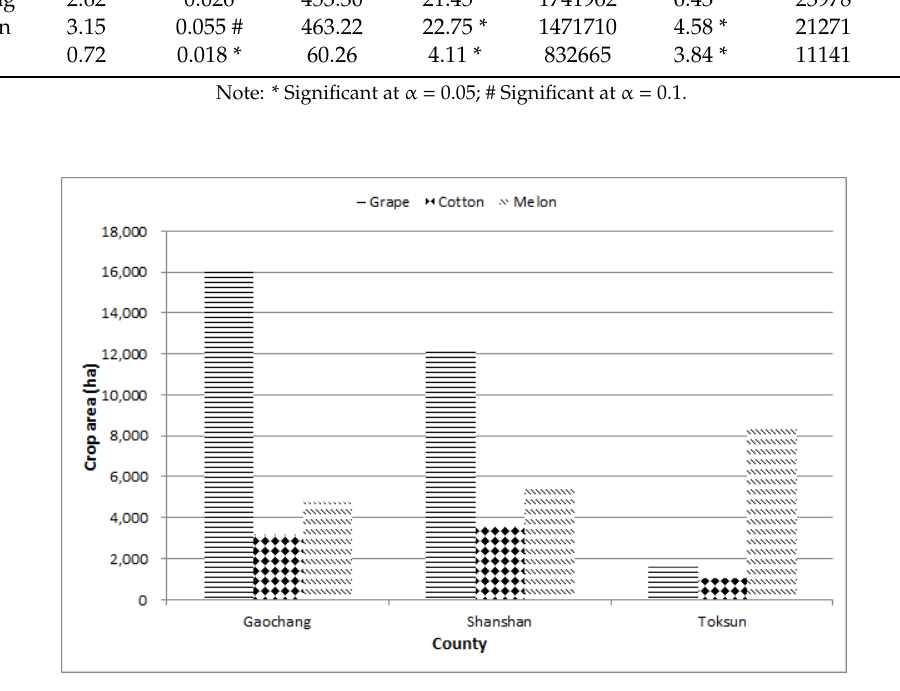
Figure 3. Average crop areas of grape, cotton and melon in the counties and district of Turpan.